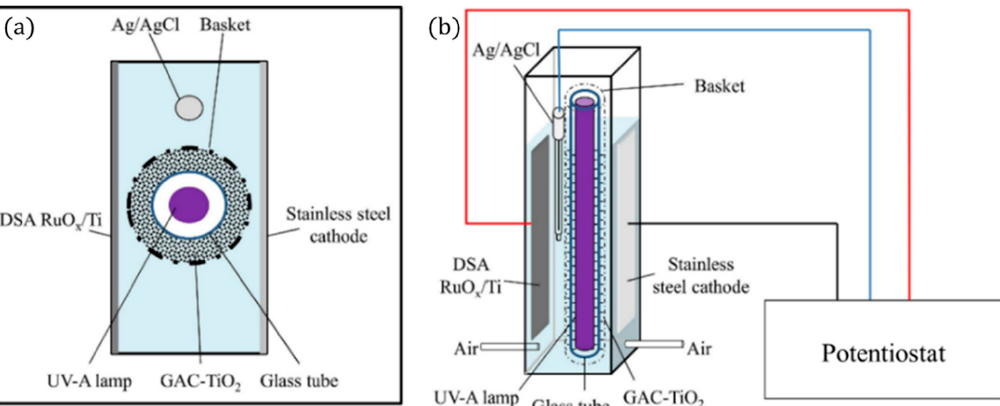
Figure 27. Schematic representation of the 3D PEC reactor, ( a ) upper view and ( b ) front view. (Adapted with permission from [107]: Mesones, S.; Mena, E.; López-Muñoz, M.J.; Adán, C.; Marugán, J. Synergistic and antagonistic effects in the photoelectrocatalytic disinfection of water with TiO 2 supported on activated carbon as a bipolar electrode in a novel 3D photoelectrochemical reactor. Sep. Purif. Technol. 2020 , 247 , 117002, doi:10.1016/j.seppur.2020.117002. Copyright (2020), Elsevier (Amsterdam, The Netherlands)).